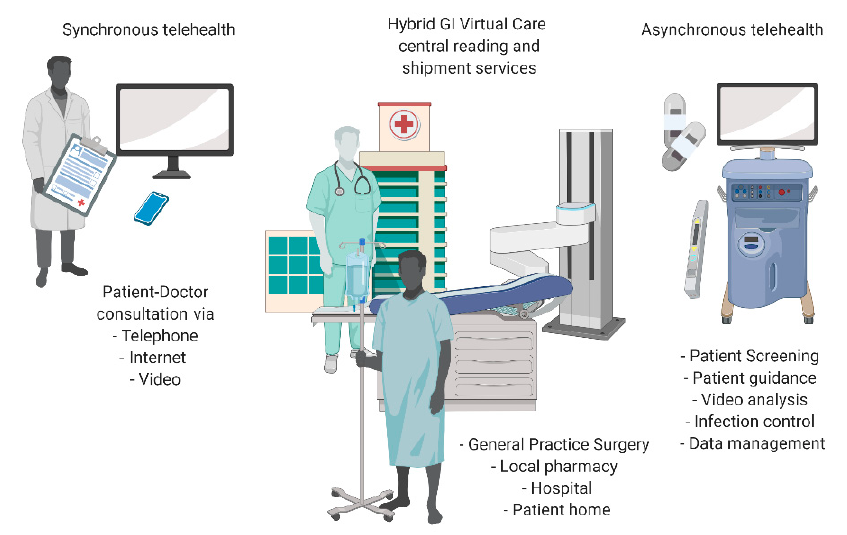
Figure 4. Remote health consultation (created with BioRender [110]).